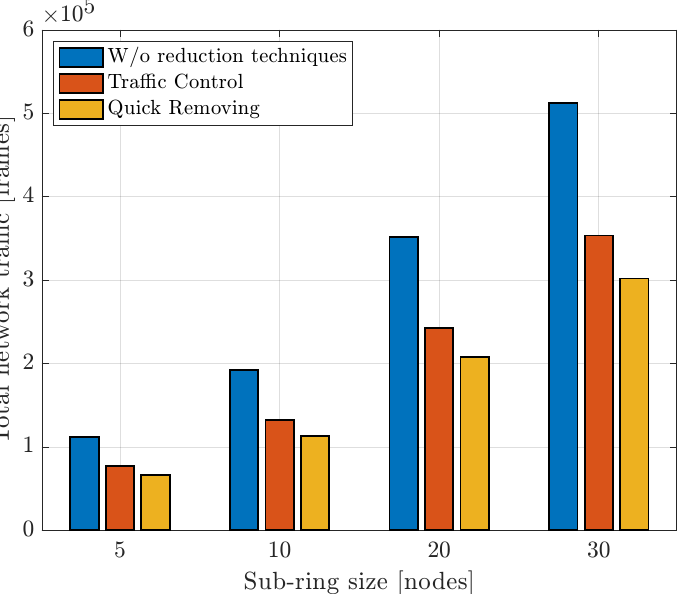
Figure 8. Traffic-reduction performance against different sub-ring sizes for the conventional